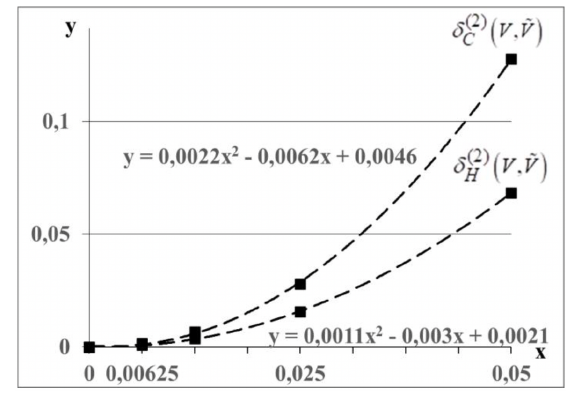
( V ) , δ (1) ( V ) , - - - graphs of H C